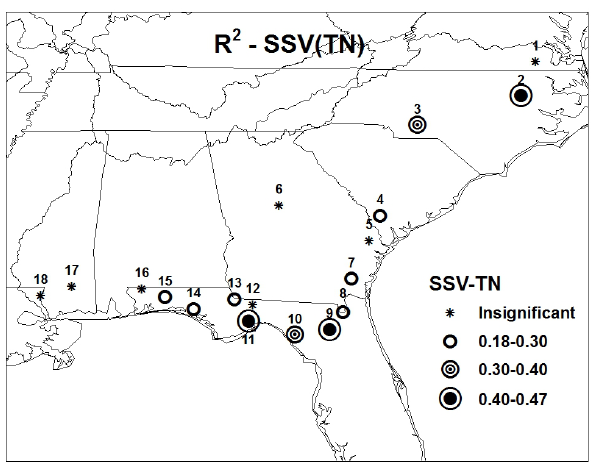
Figure 4: Modified R 2 (based on equation (3)) of PCR model predicted TN loadings obtained 2 (based on Eq. 3) of PCR model predicted TN using PC’s of forecasted precipitation under split sample validation (SSV). Fig. 4. Modified R loadings obtained using PCs of forecasted precipitation under split sample validation (SSV).